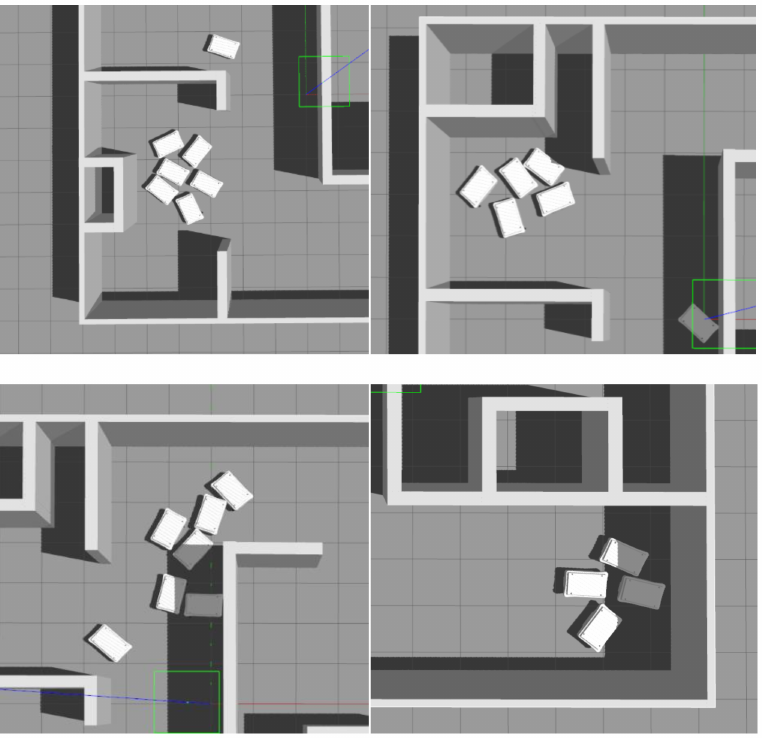
Figure 13. Typical failures in the shortest-path based (baseline) approach when having a large number of AMRs in the